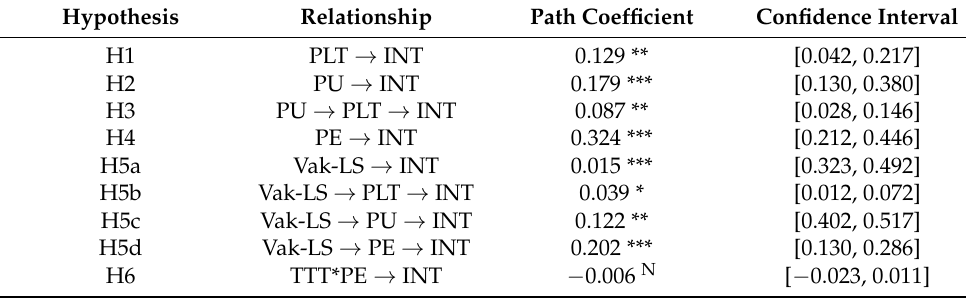
Table 9. Results of hypothesis testing.